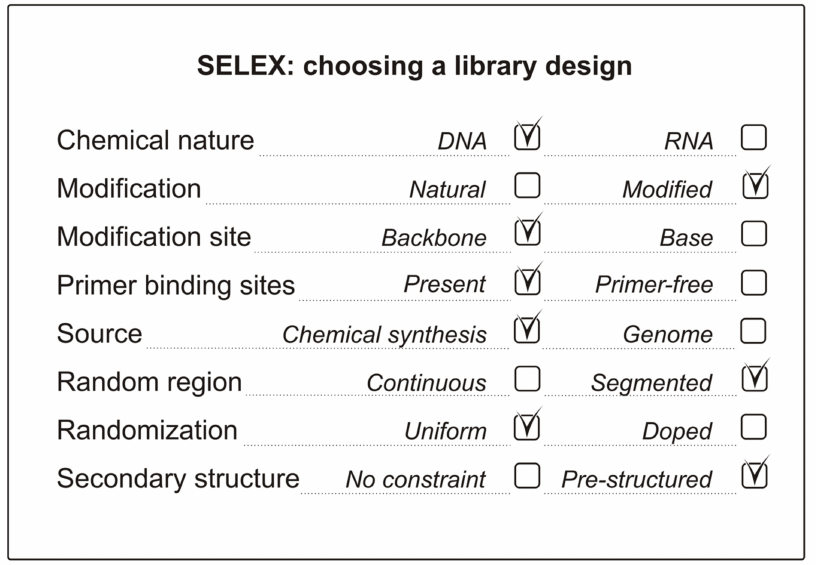
Figure 1. An example checklist for an NA library design with the key issues to be